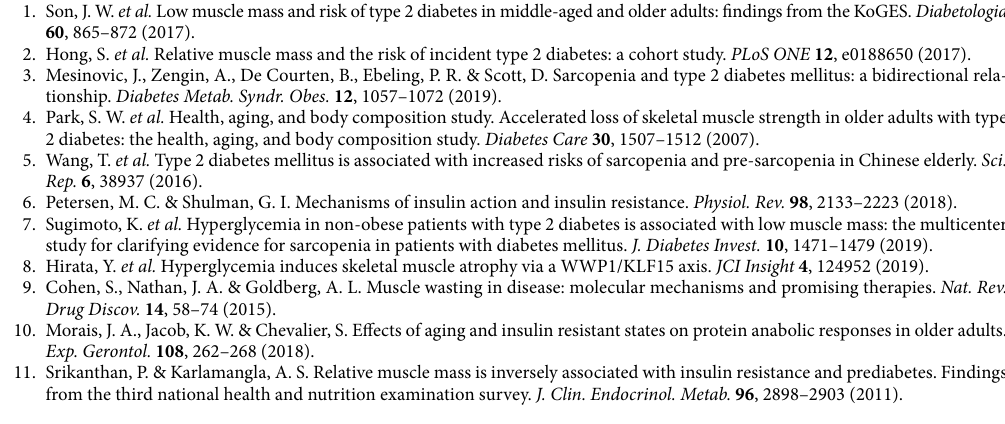
Figure 4. Role of β 2 -AR signaling in exercise-induced skeletal muscle hypertrophy. ( A , B ) : Immunoblot analysis of the abundance and phosphorylation of S6K and S6 in gastrocnemius muscle of control mice ( A ) or of control and M-PDK1KO mice ( B ) at 12 weeks of age and at 10 min after intraperitoneal injection of clenbuterol (1 mg/kg) ( A , B ), dobutamine (1 mg/kg) ( A ), or vehicle. ( C , D ) Immunoblot analysis of S6K and S6 abundance and phosphorylation in serum-deprived C2C12 myotubes infected with an adenovirus encoding PDK1 shRNA (PDK1KD) or with a control virus (empty vector) ( C ) or incubated with a pharmacological inhibitor (GSK2334470, 3 μM) for 30 min ( D ),and then incubated in the absence or presence of 100 nM clenbuterol for 10 min. ( E ) Mass of the gastrocnemius muscle 10 days after daily intraperitoneal injection of clenbuterol (1 mg/ kg) or vehicle in control and M-PDK1KO mice ( n = 4 each) at 12 weeks of age. ( F ) Immunoblot analysis of S6K and S6 abundance and phosphorylation in the plantaris muscle at 10 days after synergistic muscle ablation (or sham surgery) in control and M- Adrb2 KO mice at 12 weeks of age. ( G ) Mass of the plantaris muscle for mice as in ( F ) ( n = 4 and 5 mice of each genotype for sham surgery and muscle ablation, respectively). Each lane in ( A , B , F ) represents a sample from one mouse; each lane in ( C , D ) represents one dish, and quantitative data are shown in the right panels. Each band was quantified with the use of the ImageQuant TL software. All quantitative data are means ± SEM. * P < 0.05, NS, not significant (one-way ANOVA followed by Tukey). ( H ) Proposed role for the β 2 -AR–PDK1 signaling pathway in mechanical load induced muscle hypertrophy. Whereas PDK1 and β 2 -AR contribute to load–induced skeletal muscle hypertrophy, and that PDK1 mediates, at least in part, the effect of β 2 -AR signaling, unidentified stimuli may also contribute to load-induced muscle hypertrophy upstream of PDK1. Alterations in gene expression, which are independent of PDK1, may be attributable to the muscle hypertrophic effect. Dashed lines represent unidentified signaling